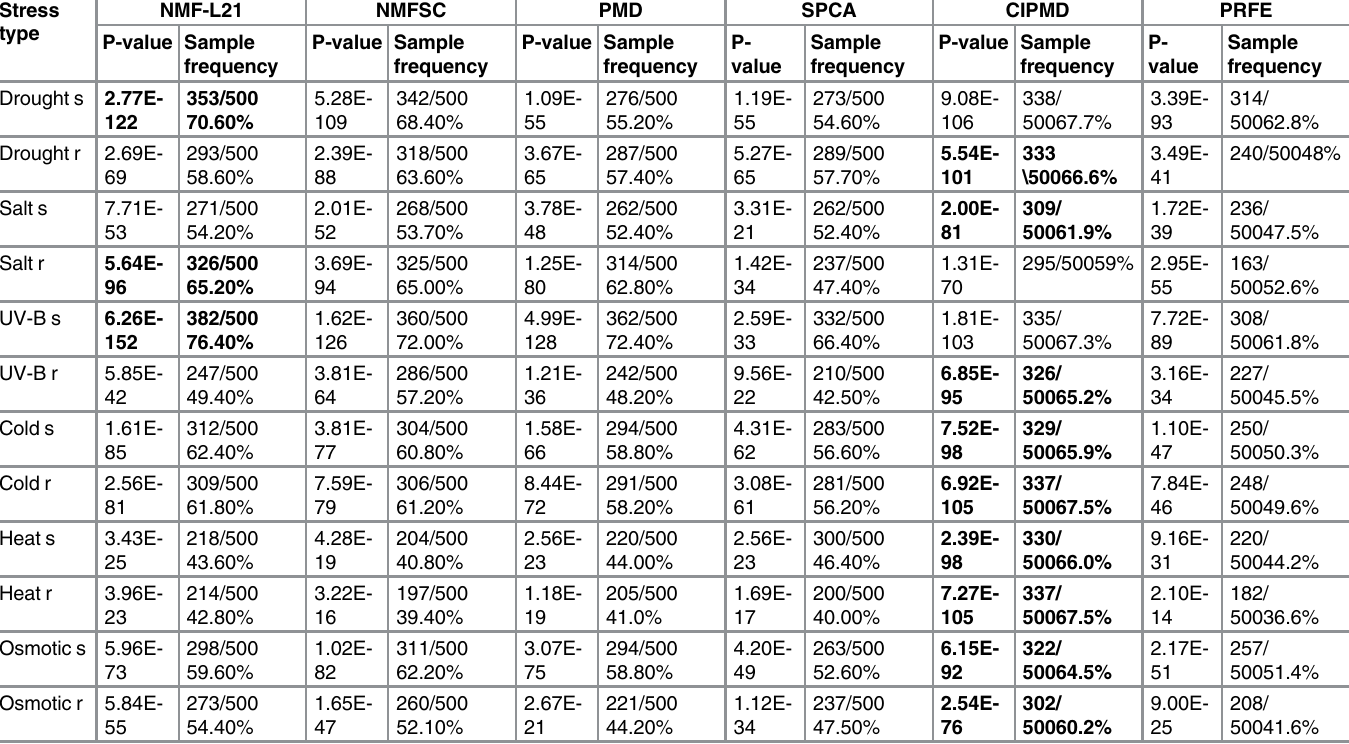
Table 3. Response to Stimulus (GO: